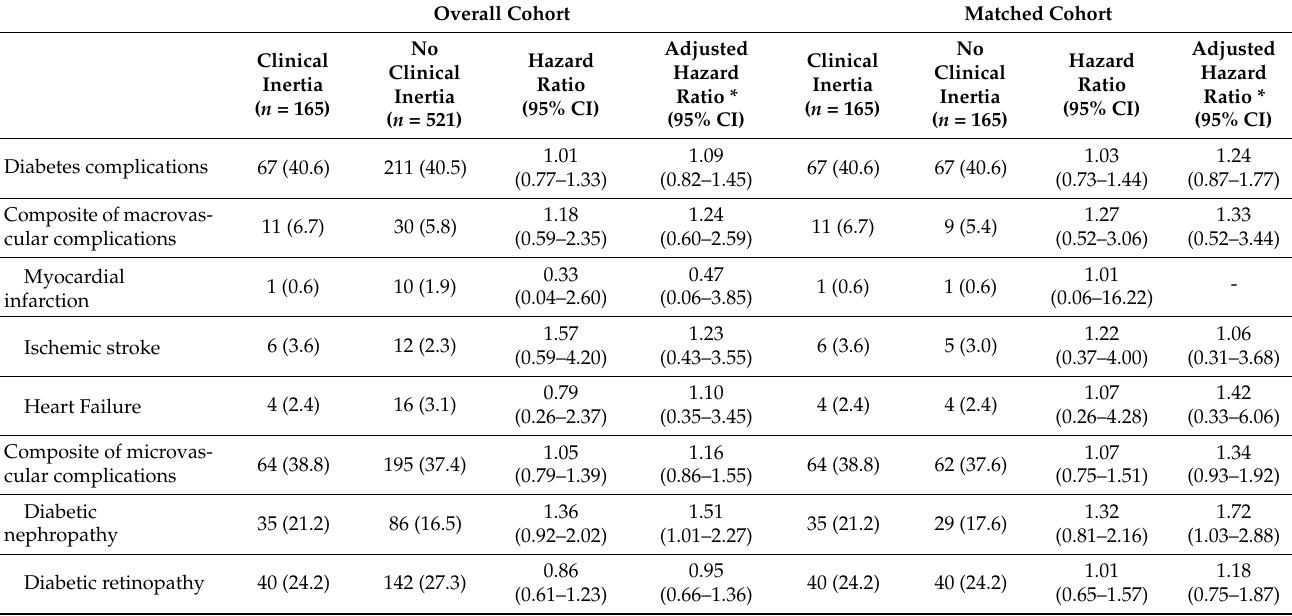
Table 2. Hazard ratios showing the effect of clinical inertia on diabetes complications ( n =